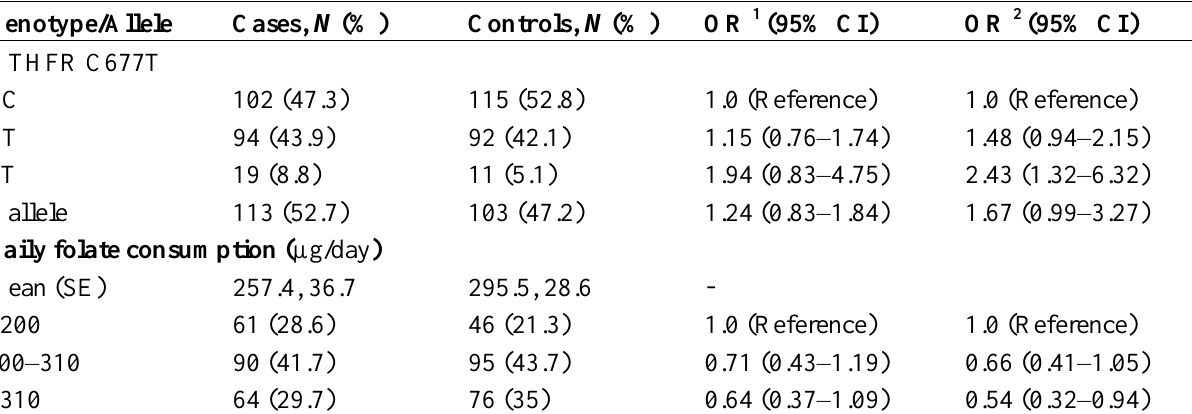
Table 2. Frequency distribution and association of methylenetetrahydrofolate